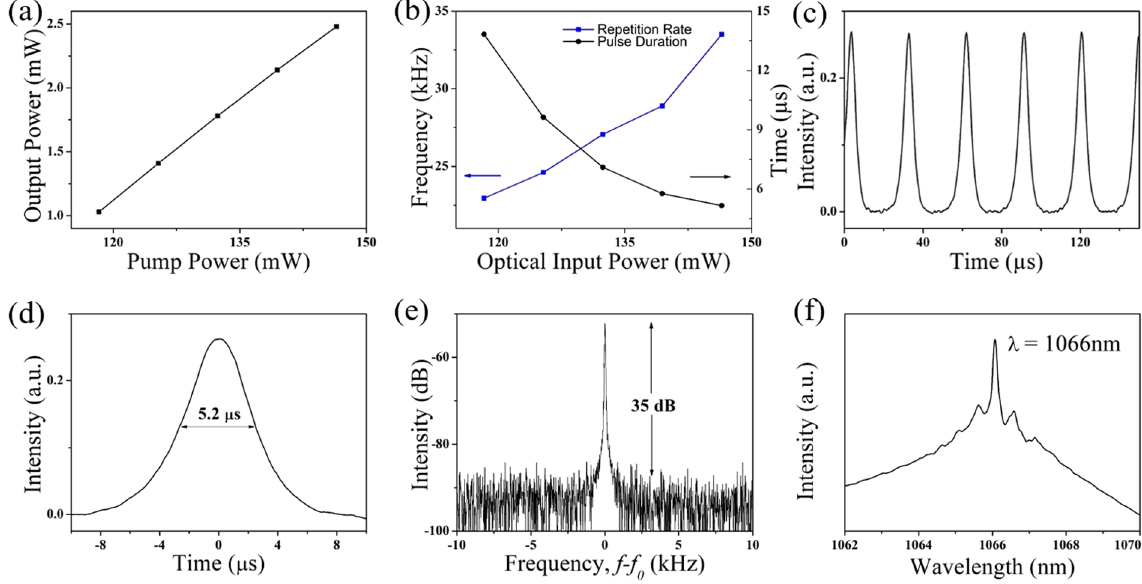
Figure 7. Q-switched laser performance: ( a ) The average output power and ( b ) Repetition rate and Pulse duration variation with respect to the different pump power. ( c ) Pulse train, ( d ) Single pulse profile, ( e ) Radio frequency spectrum, and ( f ) Wavelength spectrum corresponding to the maximum output single pulse energy of 74.0